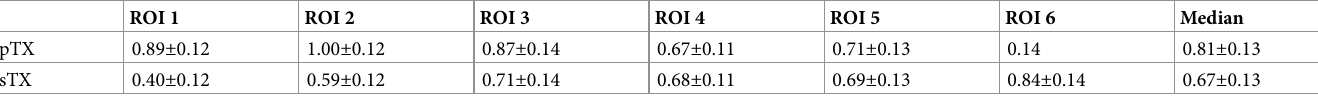
Table 3. Signal-to-noise ratio (SNR) measurements in the stenosis phantoms (blood pool). Data are mean ± standard deviation. ROI 1 ROI 2 ROI 3 pTX 0.89 ± 0.12 sTX 0.40 ± 0.12 Data are mean ± standard deviation.